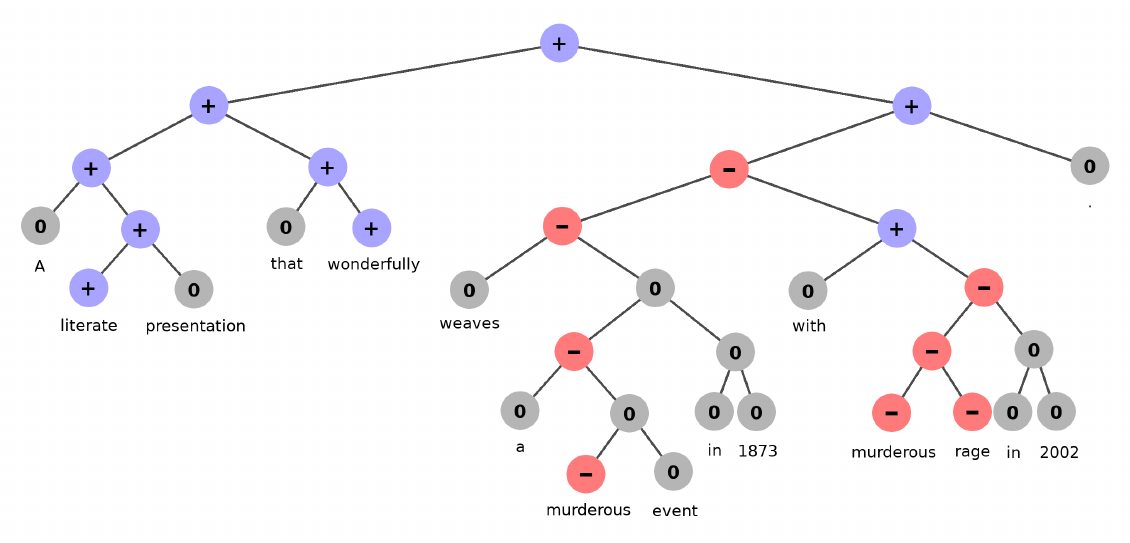
Figure 4. A parsing tree of a recursive neural network predicting word sentiment classes. The leaf nodes are input tokens, all the other nodes are representations of the combination of the child nodes. The root node is representation of the entire input text.